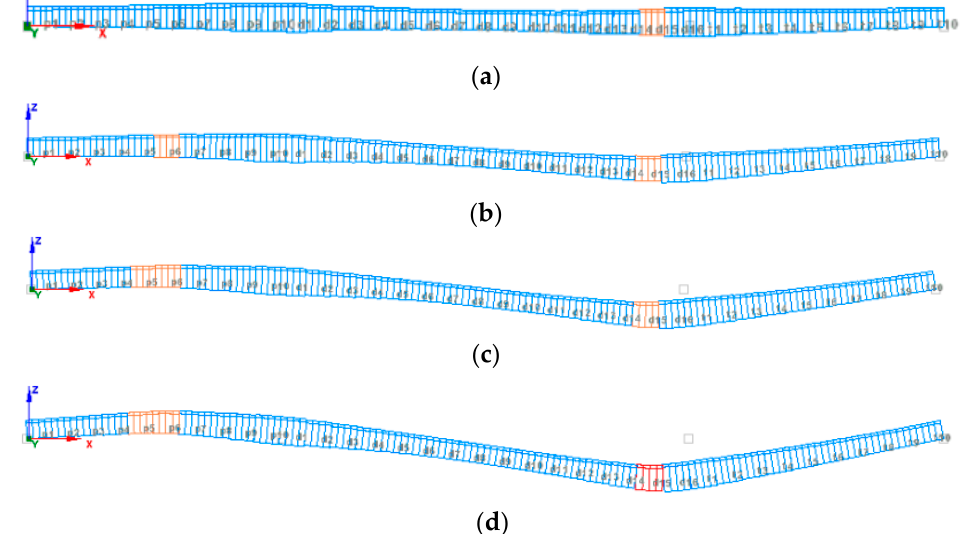
Figure 19. ( a ) Step 9: the reinforcement yield at 1.81 m from S2 pier for 0.08 m settlement of S2 pier. ( b ) Step 21: the reinforcement yield at 10.8 m from left abutment for 0.20 m settlement of S2 pier. ( c ) Step 40: the reinforcement yield at 7.2 m from left abutment for 0.39 m settlement of S2 pier. ( d ) Step 65: the chord rotation capacity reached at 1.81 m from S2 pier for 0.64 m settlement of S2 pier.